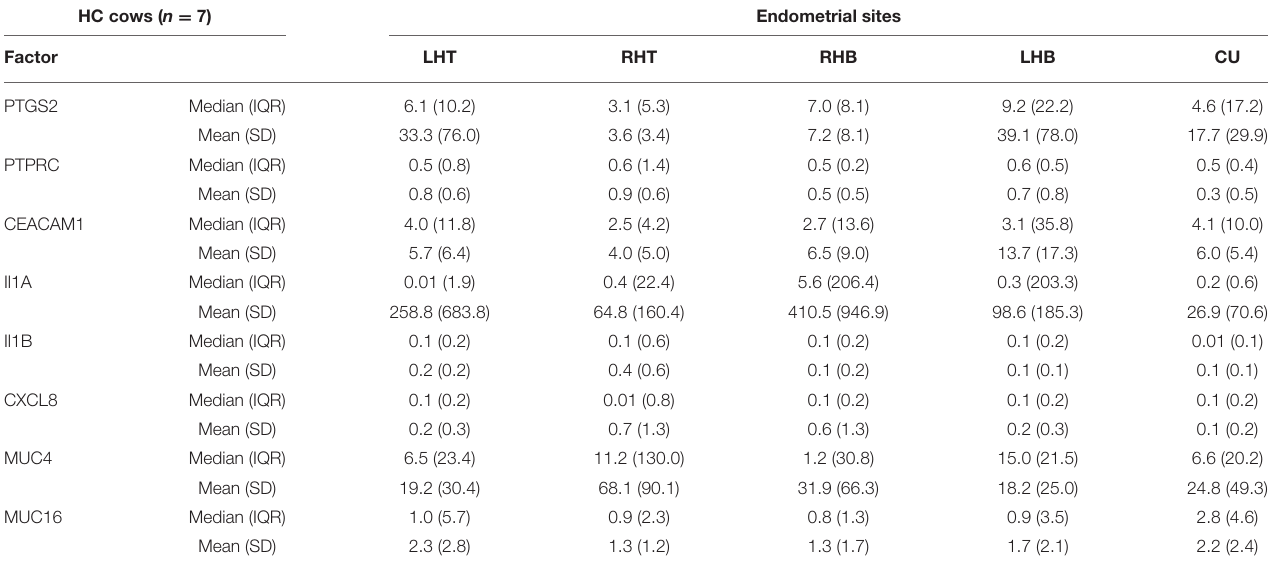
TABLE 3 | Median, interquartile range (IQR), mean, and standard deviation (SD) of normalized mRNA expression for different pro-inflammatory factors and mucins in the endometrium at the corpus uteri (CU), the base of the left horn (LHB), the tip of the left horn (LHT), the base of the right horn (RHB) and the tip of the right horn (RHT) collected from seven healthy cows (HC) on day 28 to 34